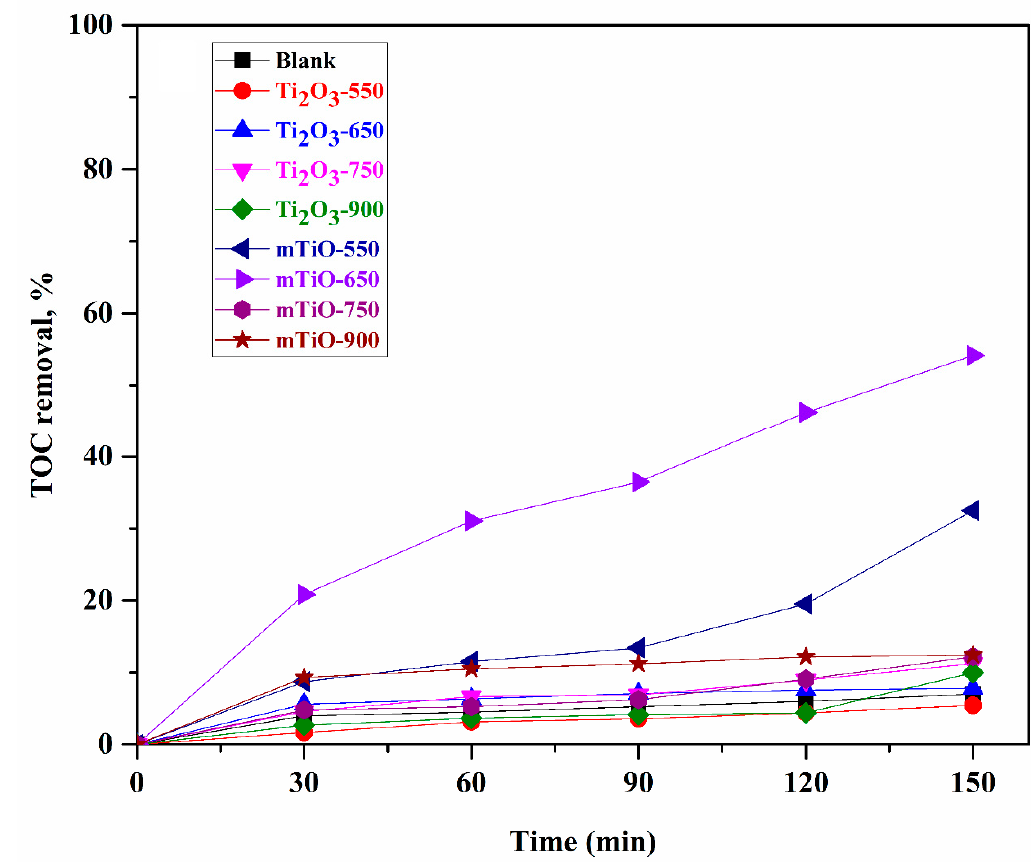
Figure 15. TOC removal under solar light irradiation in the presence of prepared catalysts. [4-t-BP] 0 = 5 mg/L, [photocata- lyst] = 200 mg/L.